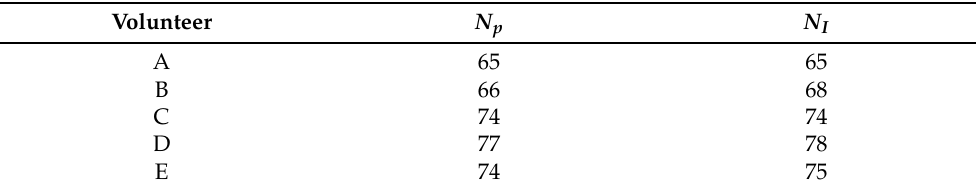
Table 3. Comparison of the pulse values of the volunteers detected by using STA and by employing a professional pulse